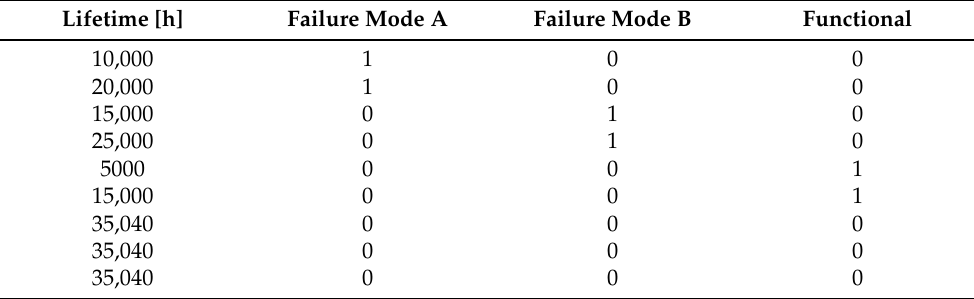
Table 1. Example of a table to censor data according to the failure mode and